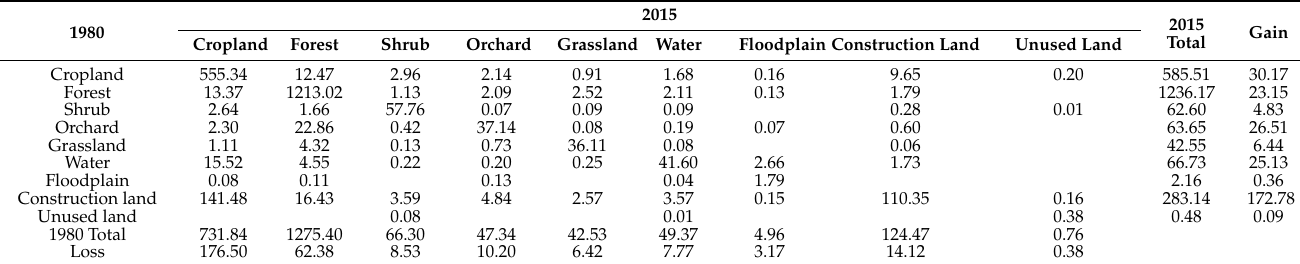
Table 2. Land use types conversion matrix between 1980 and 2015 (km2).